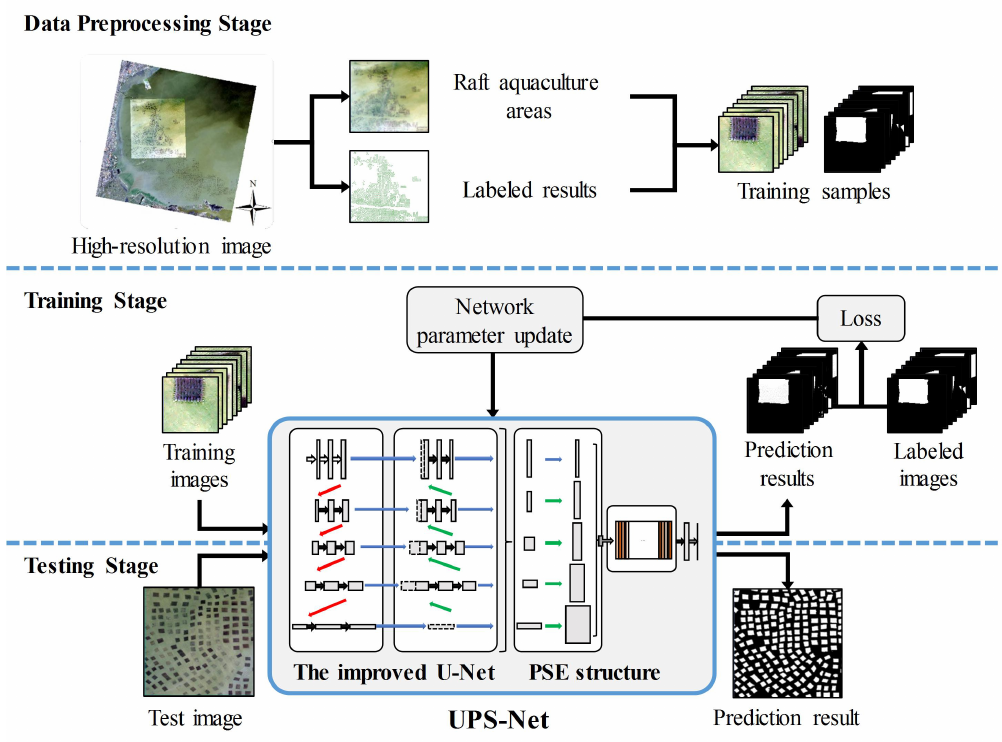
Figure 4. The general process of our raft aquaculture areas extraction. The data preprocessing stage, the training stage and the testing stage are illustrated in the upper , middle , and lower parts of the figure, respectively. The UPS-Net model is a simplified version of the